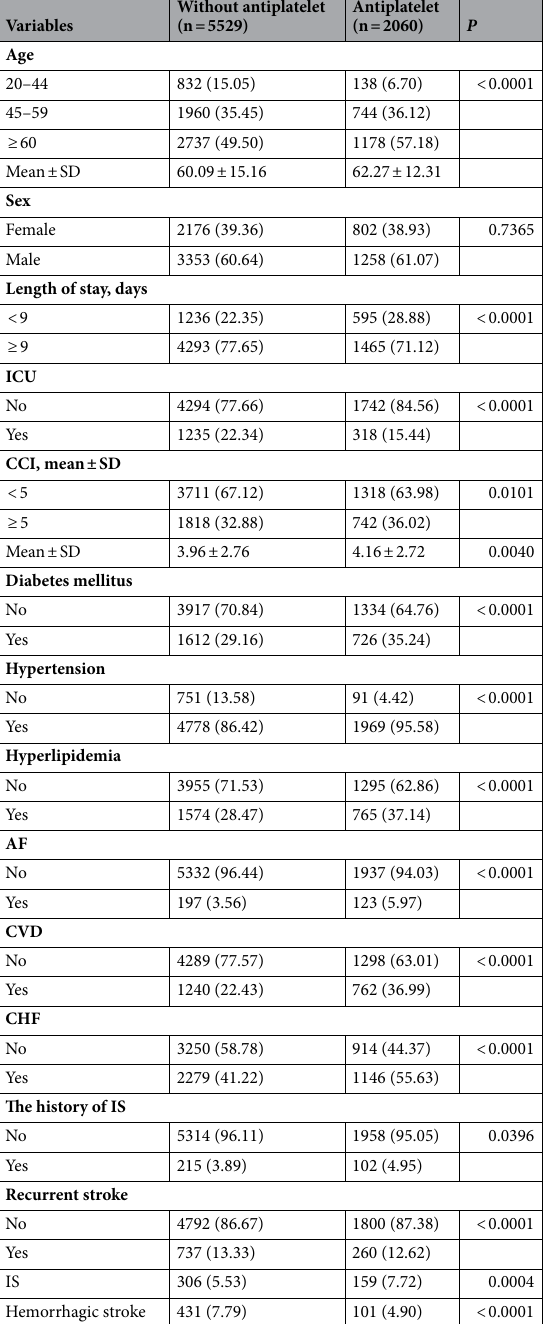
Table 1. Characteristics of the patients with hemorrhagic stroke (n = 7589). ICU, intensive care unit; CCI, clinical comorbidity index; AF, atrial fibrillation; CHF, congestive heart failure; IS, ischemic stroke; SD, standard deviation; CVD, cardiovascular